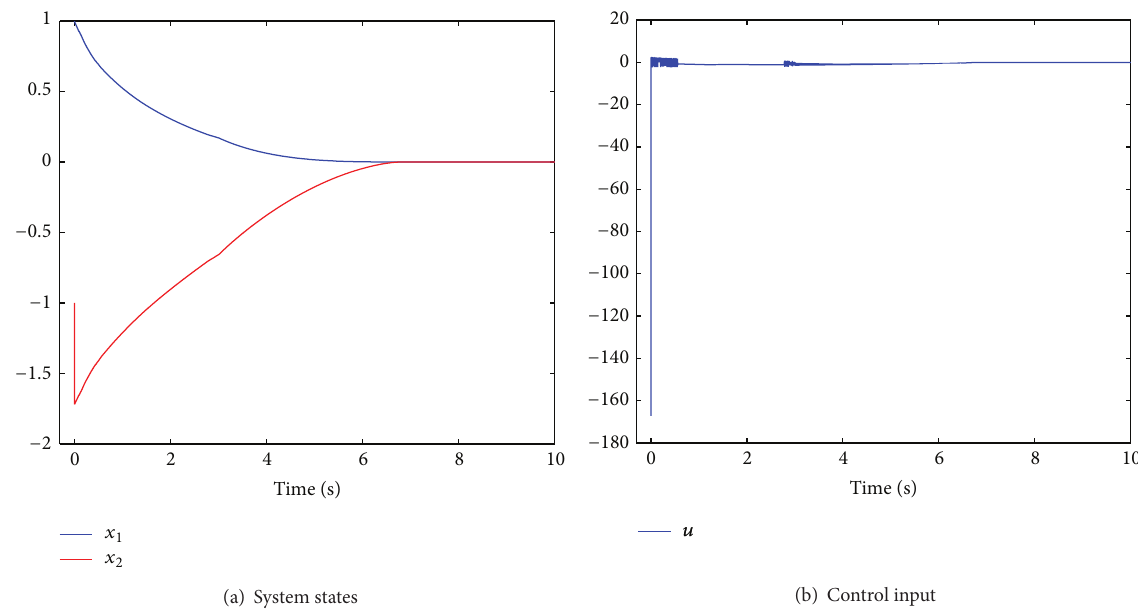
Figure 1: The responses of the closed-loop system (38) and